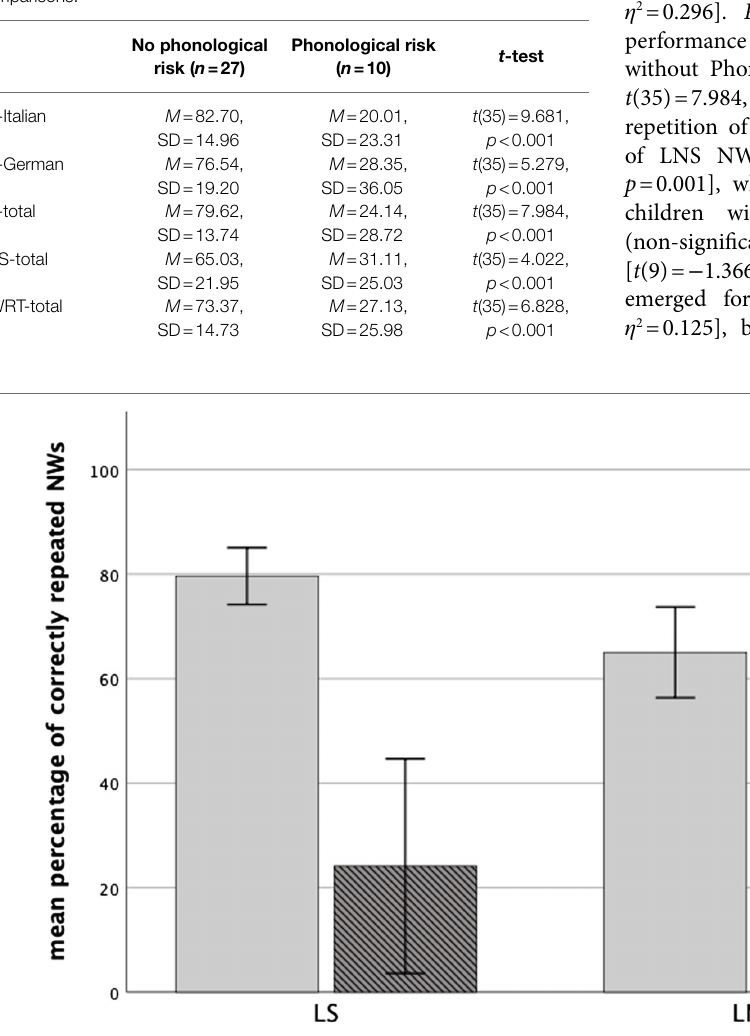
TABLE 3 | Mean percentages of correctly repeated NW for all MuLiMi NWRT scales according to children’s phonological risk status at T1, and t -test comparisons.